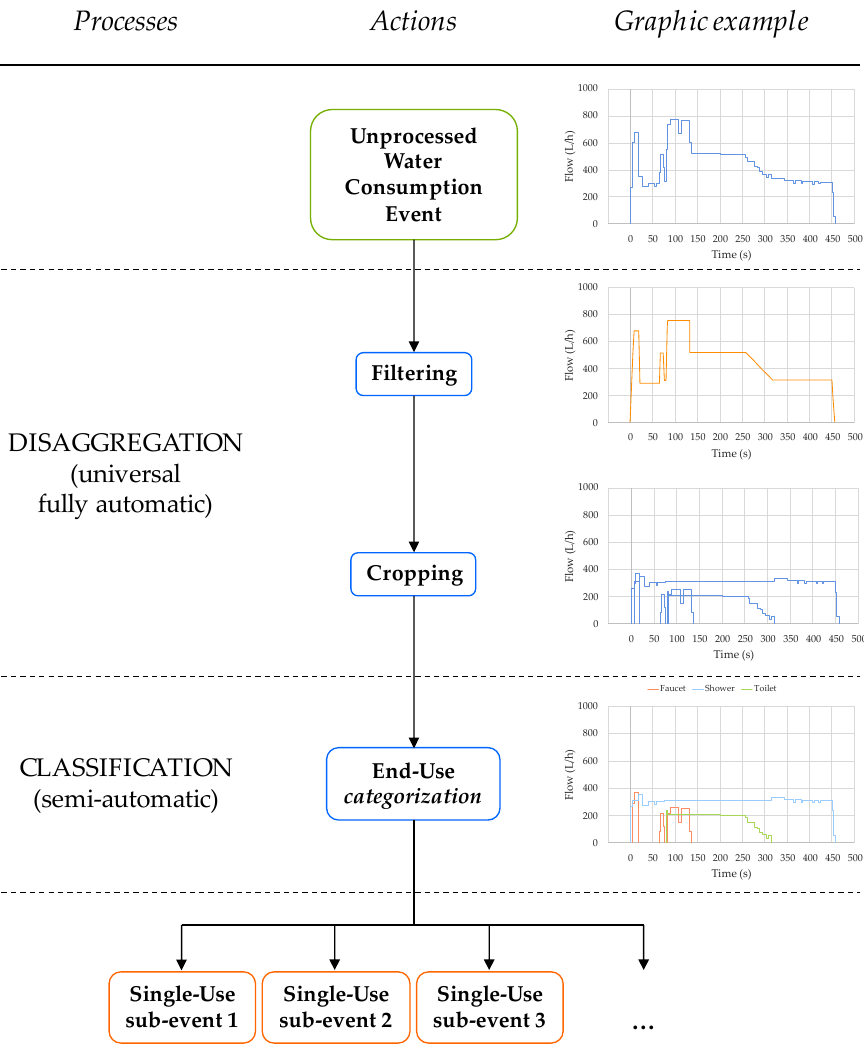
Figure 1. General structure of the proposed methodology.